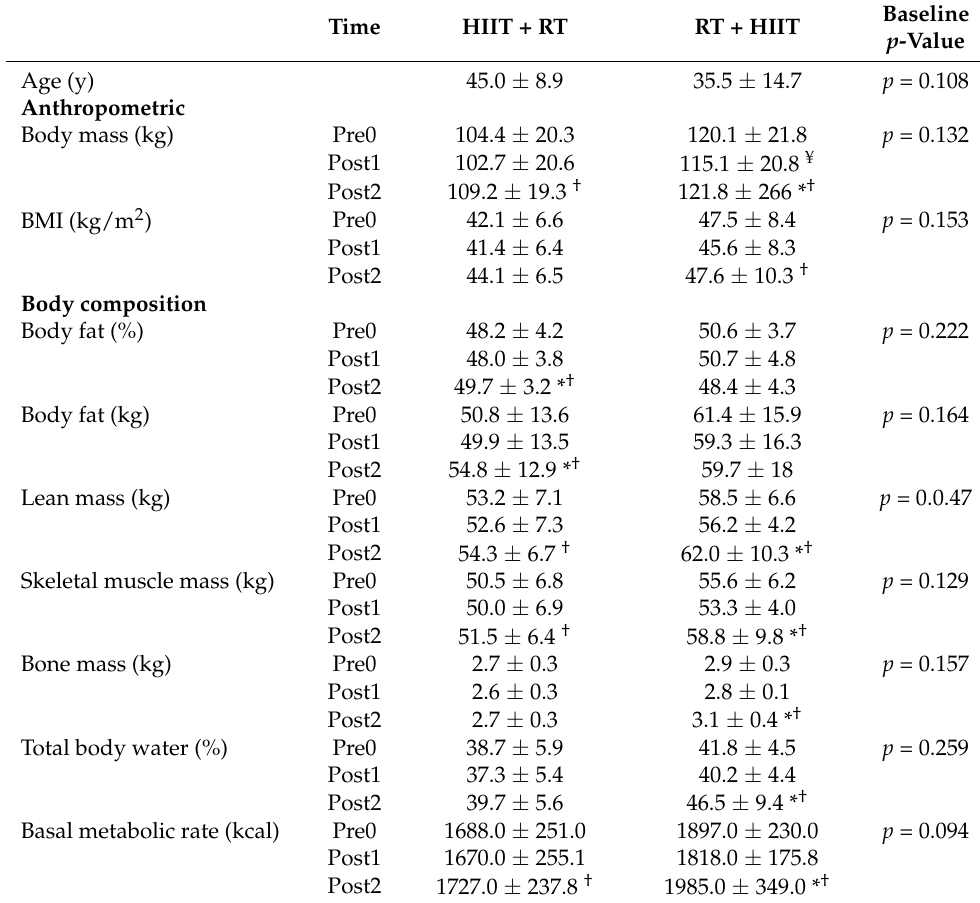
Table 1. Comparison between groups according to anthropometric and body composition